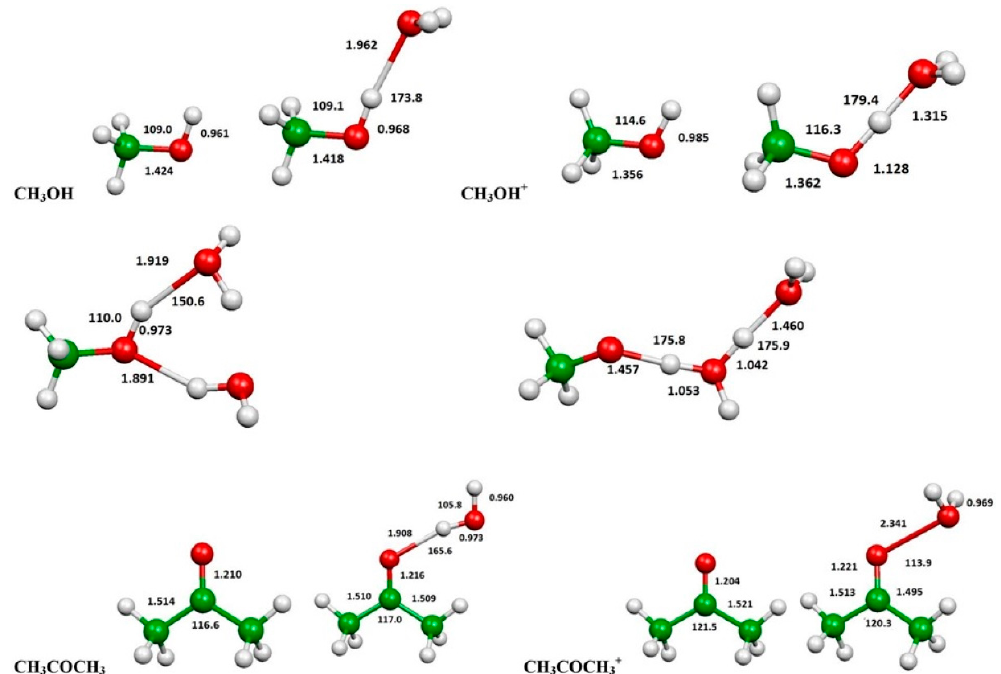
Figure 8. B3LYP optimized geometries (Å, and °) of the gas phase methanol and acetone neutrals and radical cations with and without surrounding water molecules (see text). The H 2 O—HOCH 3 distance, which is 1.962 Å in the neutral system, becomes 1.315 Å in the ionized complex; moreover, the methanol O—H bond length increases from 0.968 Å to 1.128 Å and the O—H—O angle, which is 173.8° in the neutral system, becomes 179.4° in the ionized one. The geometry of the complex (CH 3 OH … OH 2 ) + ∙ suggests, therefore, the presence of a hydrogen bond between methanol radical cation and water molecule. This is also confirmed by the Mulliken charges, reported in Figure 9 for methanol and acetone, which shows a charge transfer of 0.29 e from the water molecule to the ionized methanol molecule.